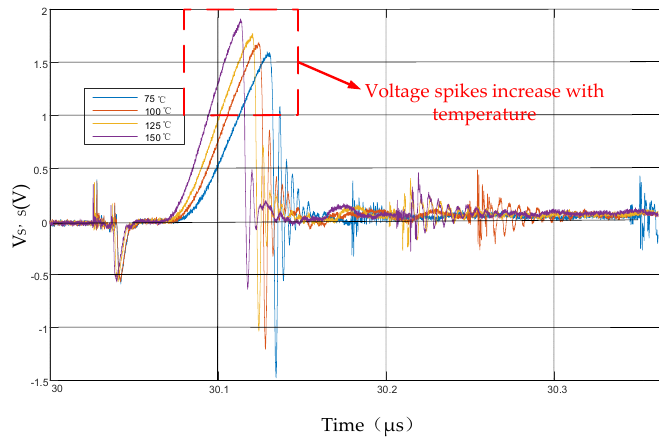
Figure 5. Parasitic inductance L S induced the voltage waveform at turn ‐ on.